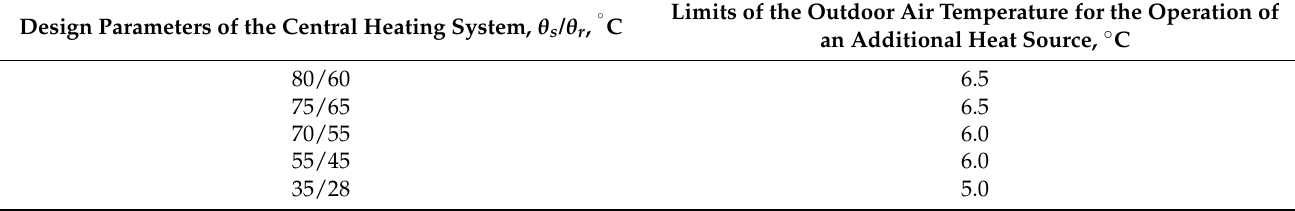
Table 5. Limits of the outdoor air temperature for the operation of an additional heat source. Limits of the Outdoor Air Temperature for the Operation Design Parameters of the Central Heating System, θ s / θ r , ◦ C